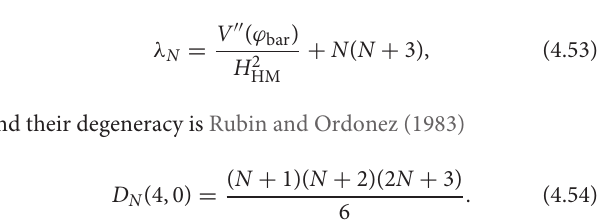
FIGURE 6 | CdL bounce decay exponent plotted against the Hawking-Moss solution in the Standard Model with M t GeV, α S ( M Z ) 0.1184. The critical values H crit =